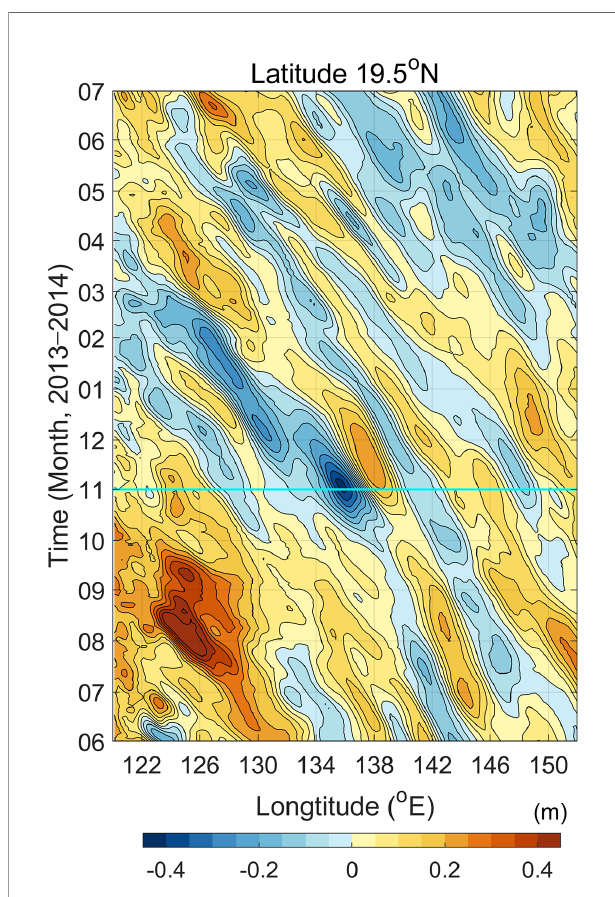
FIGURE 6 | Longitude-time Hovmöller diagram of sea level anomaly (m) at 19.5°N. Zonal cyan line denotes October 31 st in 2013 when the notable sea- level drops occurred by the three typhoons as shown in Fig